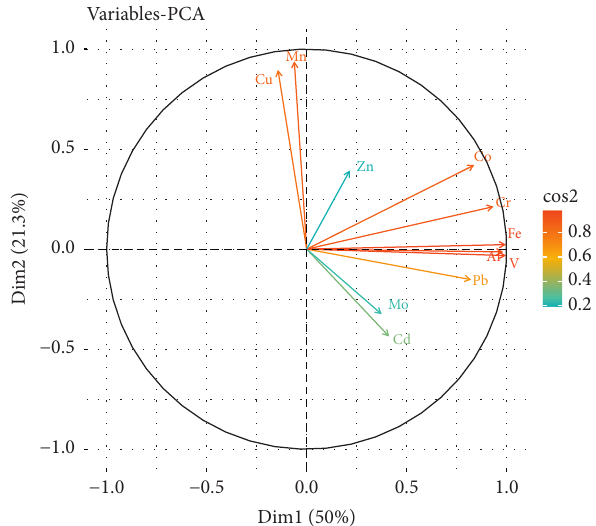
Figure 6: The quality of representation of the variables on factor map